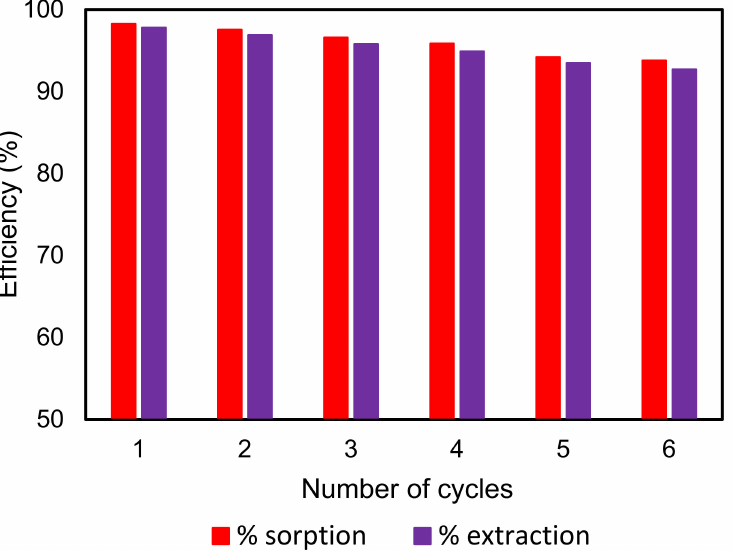
Figure 9. Reusability study of poly(amidoxime) in 6 cycles of adsorption-desorption of Co 2+